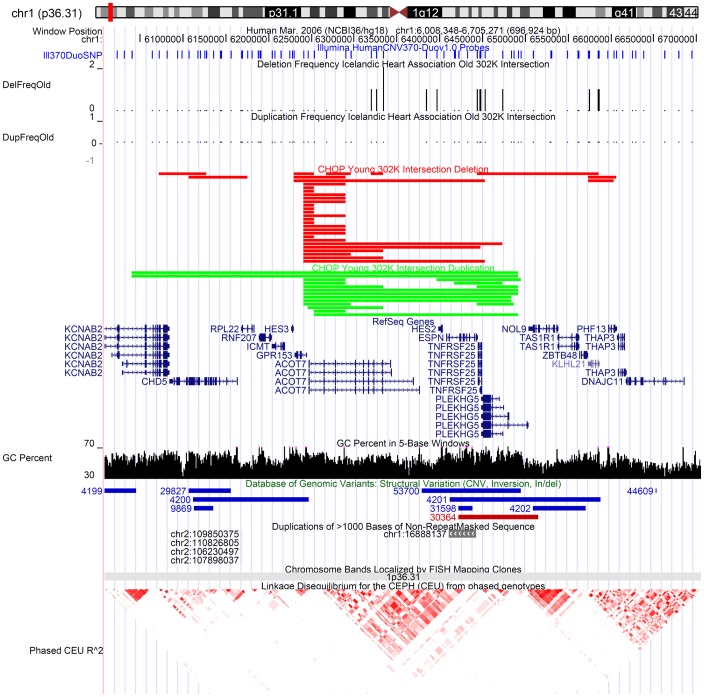
Regions of CNV in Young Individuals observed at low levels in Older Individuals.
ACOT7 locus shows significant excess of deletions and duplications in young individuals. Blue lines indicate SNP marker coverage to resolve CNV boundaries. Histogram shows the number of subjects with deletion and duplication CNVs in the Icelandic older population (very low). The red and green boundaries show individual CNVs observed in specific young samples from CHOP. Genomic region references including GC percent, RefSeq Genes, and Database of Genomic Variants are provided for reference.